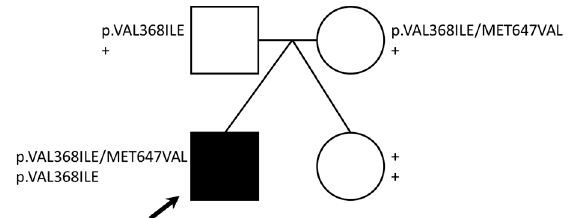
Figure 2. CPT2 variants identified. The pedigree shows genotypes for two CPT2 missense variants identified for each family member. Note: + = wild-type genotype, black arrow = proband. Asecondidentified CPT2 variant(NC_000001.10:g.53679229A > G(GRCh37); NM_000098.2:c.1939A >